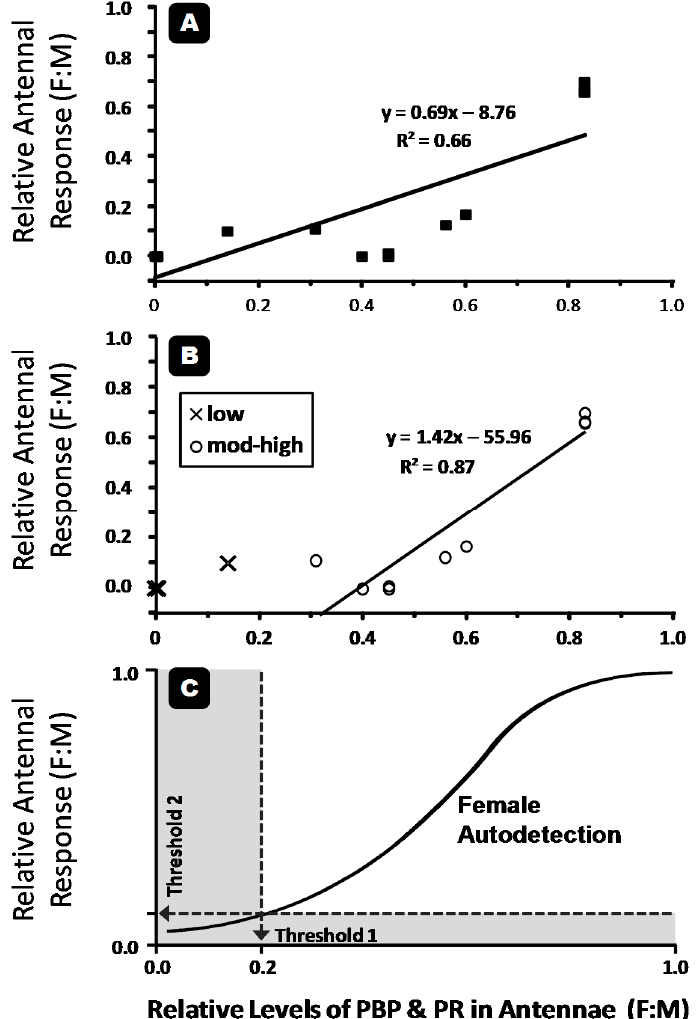
Figure 2. Relationships between relative levels of pheromone-binding (PBR) and pheromone-receptor (PR) proteins in female antennae of 14 species (see Table 4) and their relative antennal response: for all species ( A ); for species divided into two distinct groups based on levels of protein expression, a group that had little to no protein in their antennae ( ≤ 20% = “low”), and thus considered anosmic, and those that had higher levels of protein in their antennae ( ≥ 30% = “mod-high”), and thus considered here as autodetectors ( B ); and a theoretical relationship between relative levels of proteins in female antennae and their relative antennal response ( C ): species traditionally considered anosmic should fall in the gray areas below thresholds 1 and 2, while autodetecting females should fall somewhere along the linear portion of the curve.